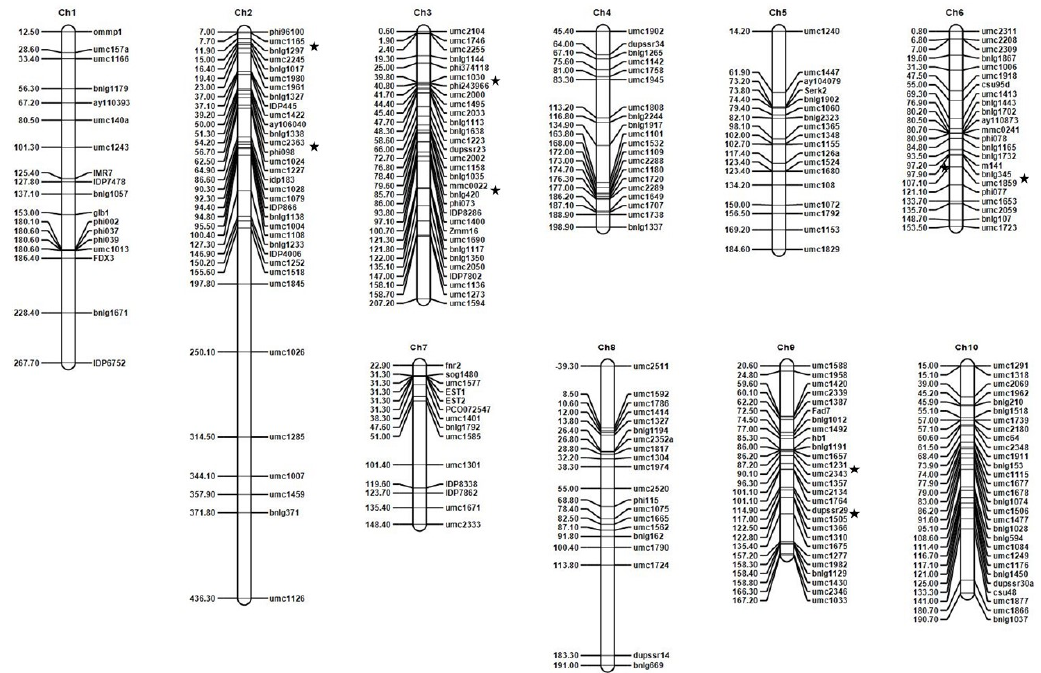
Figure 2. The linkage map of the F 7 families of the cross between B73 (susceptible) and Ki11 (resistant). For each chromosome, the chromosome number is shown at the top, the markers on the right side, and the genetic distances in cM calculated using the Kosambi function on the left side. ★ , a quantitative trait locus (QTL) position.